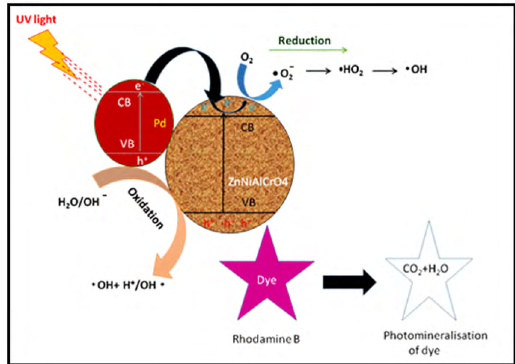
Scheme 2. Photocatalytic degradation mechanism of